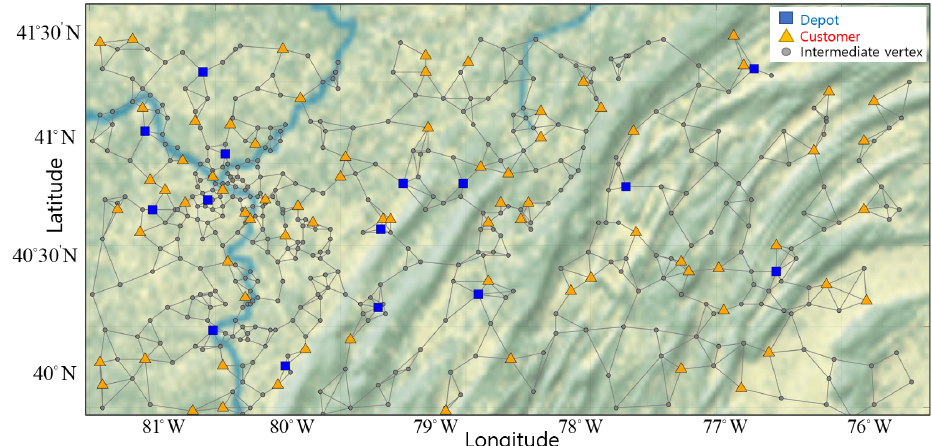
Figure 1. The proposed network configuration with multiple depots, customers, and intermediate